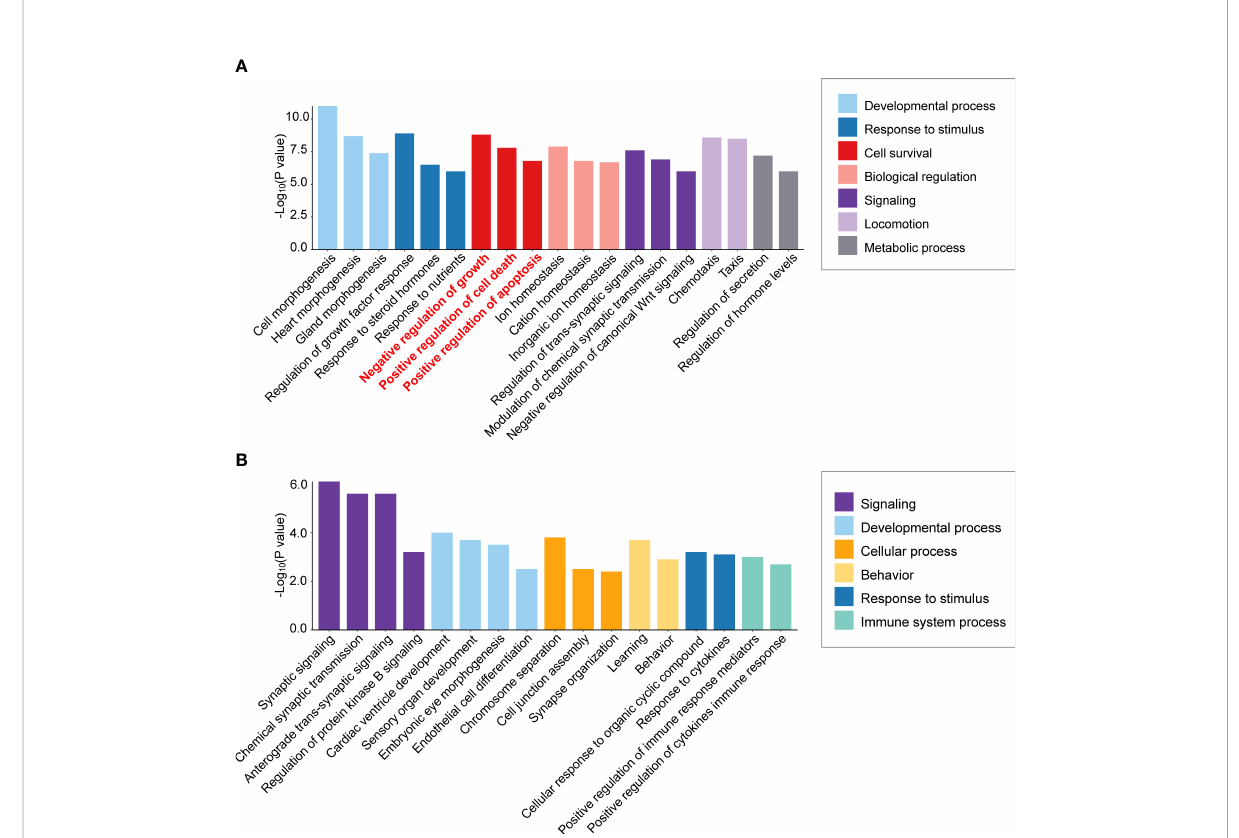
FIGURE 2 Differential enrichment of cell survival pathways in aldosterone-producing adenomas according to KCNJ5 (GIRK4) mutation status. Biological process enrichment analysis was performed of signi fi cantly differentially expressed genes in macro versus micro APAs ( ≥ 30 mm versus ≤ 10 mm adenoma diameter) without a KCNJ5 mutation (A) and with a KCNJ5 mutation (B) using Metascape (http://metascape.org/accessed on